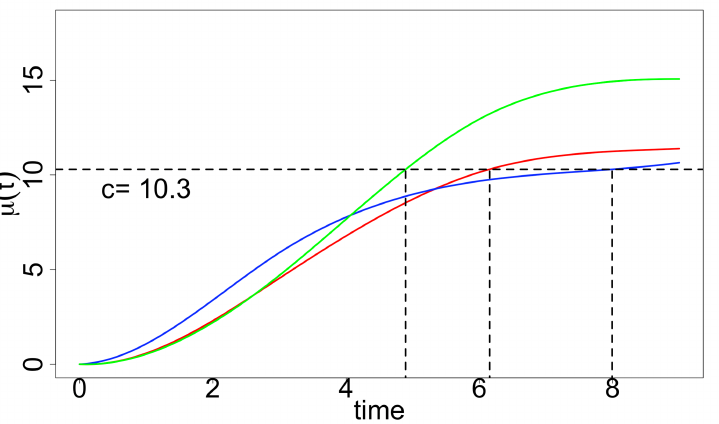
Figure 2. Fitted curves estimated with constraints (factors 1–3 are in red, blue and green, respectively); ˆ θ = 10.3) is indicated by vertical lines i given by a specified level ( c